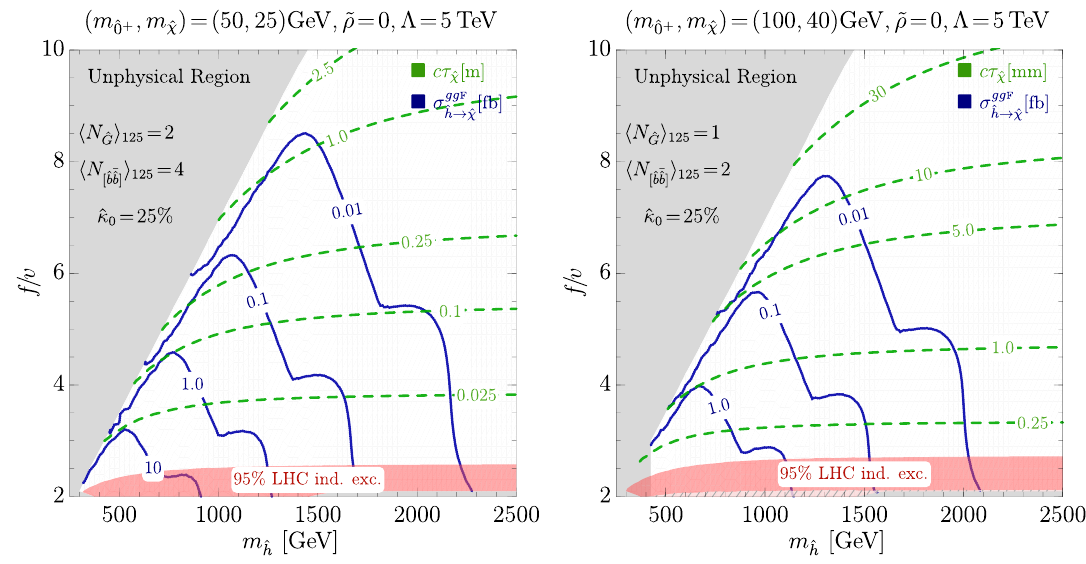
Figure 14 . These graphs show the contours of cross-sections (solid blue) and decay-lengths (dashed green) of twin bottomonium state ^ (cid:31) 0 with mass m ^ (cid:31) = 25 GeV and 40 GeV in the left- and right- panel, respectively. Moreover, we consider m ^0 = 50 GeV (left) and 100 GeV (right) for ~ (cid:26) = 0. +